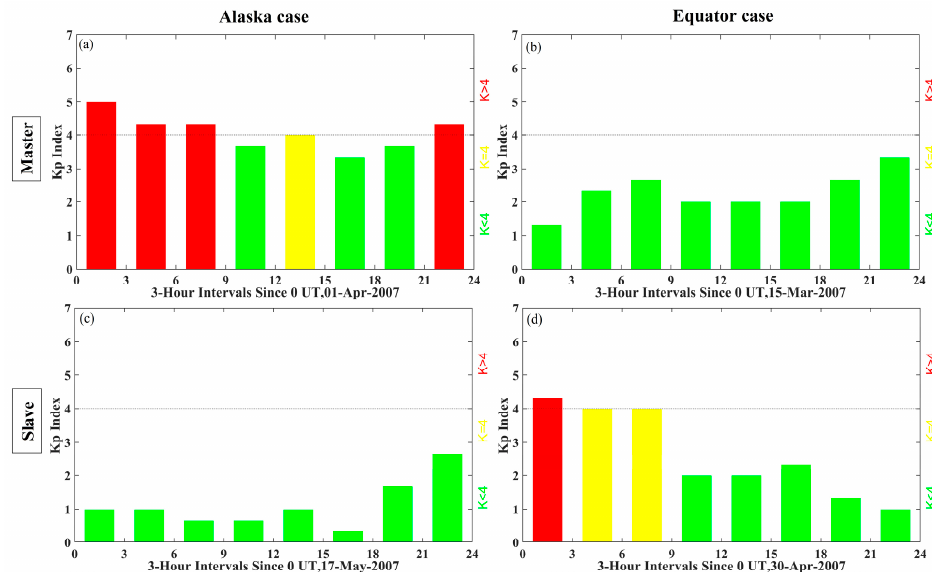
Figure 2. ( a , c ) the global geomagnetic activity index Kp corresponds to the Alaska case, ( b , d ) the index Kp corresponds to the Equator case. The red, yellow and green squares indicate different levels of geomagnetic activities.